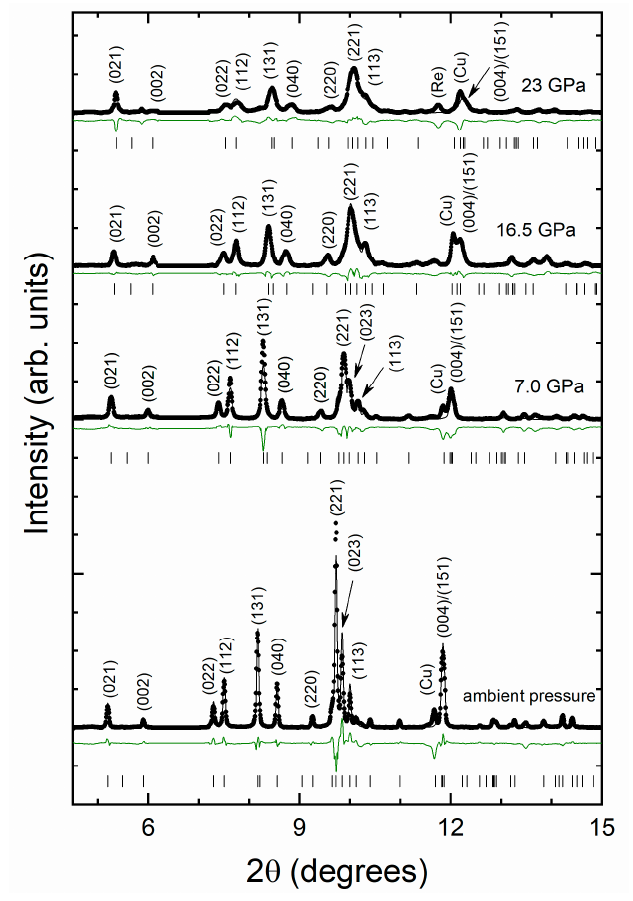
Figure 3. Integrated XRD patterns of Ni 3 V 2 O 8 from 0 to 23 GPa. Pressures are indicated on each pattern and the Bragg planes corresponding to the most intense reflections have been labeled. The experiments are shown with symbols. The refinements, assuming the ambient-pressure orthorhombic structure, are shown with black lines. The di ff erence between the observed data and Le Bail refinement is shown in green. Ticks indicate the positions of Ni 3 V 2 O 8